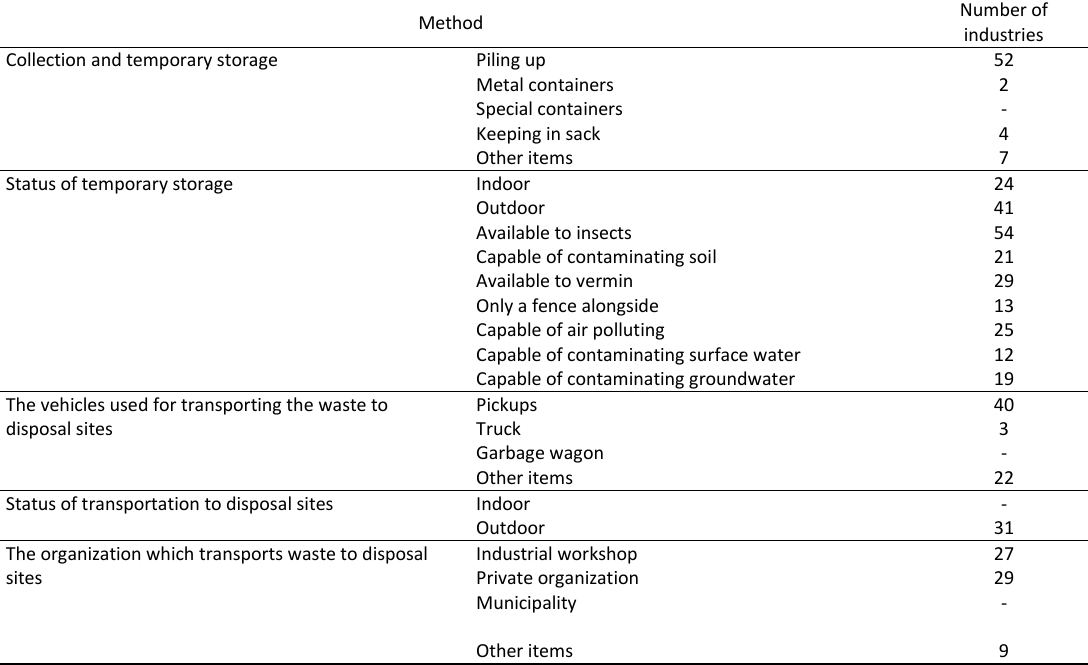
Table 3: The methods of collecting, temporary storage and waste transport in Brujen industrial park Method